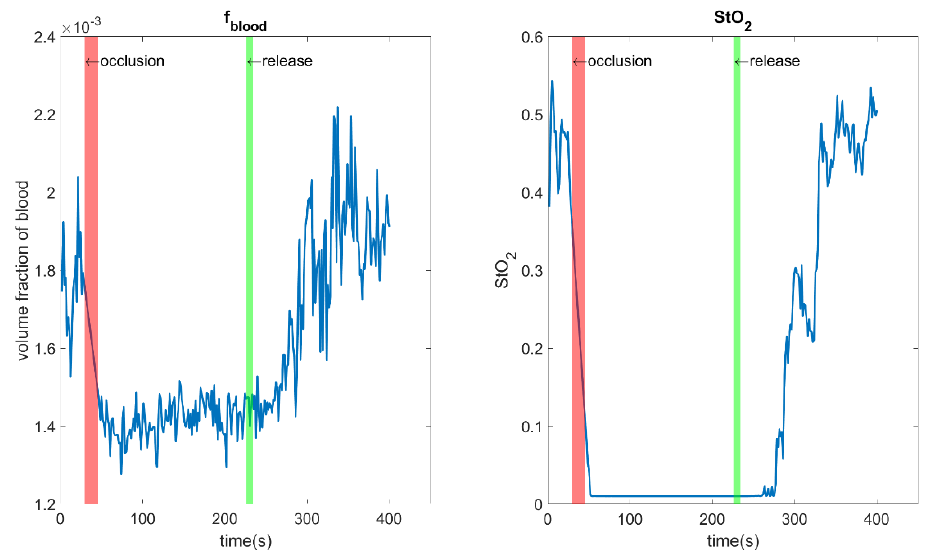
10 of 16 Figure 5. Example of fitted spectra and target in-vivo spectra measured from detection fibers located at SDS equal to ( a ) 0.22 mm, ( b ) 0.45 mm, and ( c ) 0.73 mm. Example results of extracted f blood and StO 2 in the arterial occlusion and the venous occlusion experiment are shown in Figures 6 and 7, respectively. Although there are some fluctuations in the curves of f blood and StO 2 which are likely caused by motion artifacts, f blood and StO 2 during the occlusions apparently deviated from the baseline and the deviations were much larger than standard deviations during the baselines. The decreases in StO2 during both occlusions are similar to results reported in previous studies [33,37 – 40], and are expected because tissue consumes oxygen and no oxygenated blood is supplied under the occlusions. We observed that f blood decreased slightly during